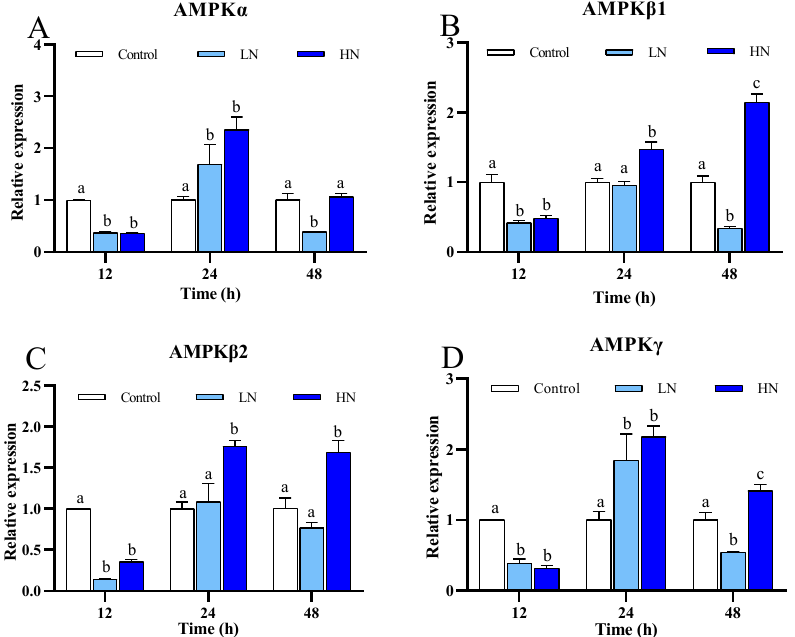
Figure 2. mRNA expression of four genes of AMPK of juvenile P. trituberculatus under nitrite stress. ( A ) AMPK α , ( B ) AMPK β 1 , ( C ) AMPK β 2 , ( D ) AMPK γ . At each time point, the letters indicate significant differences between experimental groups ( p < 0.05).